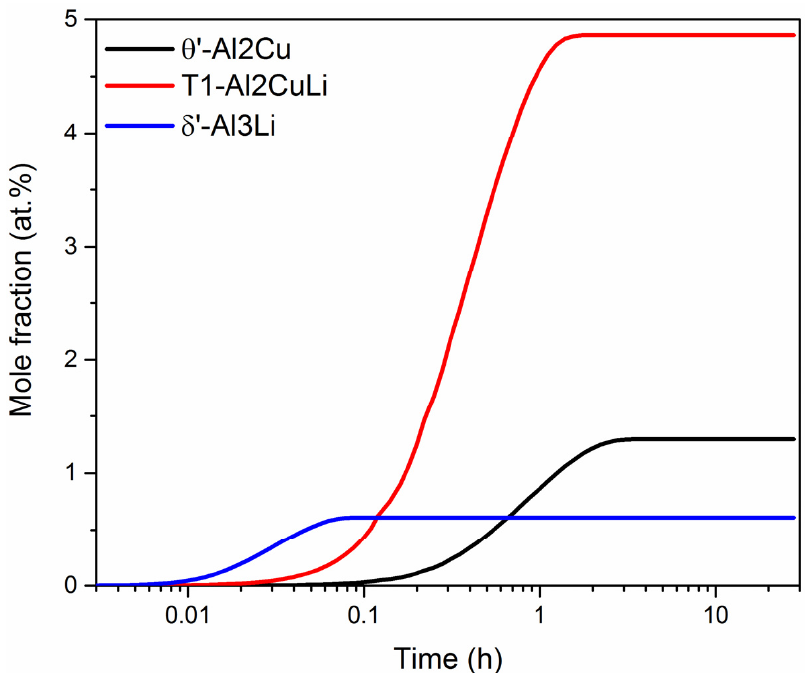
Figure 15. The kinetic curves of 2A97 alloy at 200 °C.